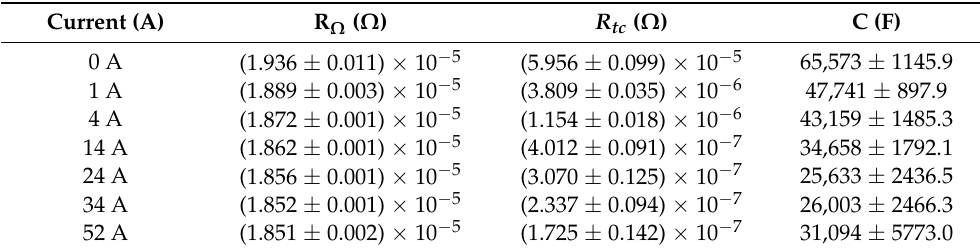
Table 2. Ohmic resistance ( R Ω ), charge transfer resistance ( R tc ), and capacitance (C) fitting values of filter EIS curves. Equation (21).